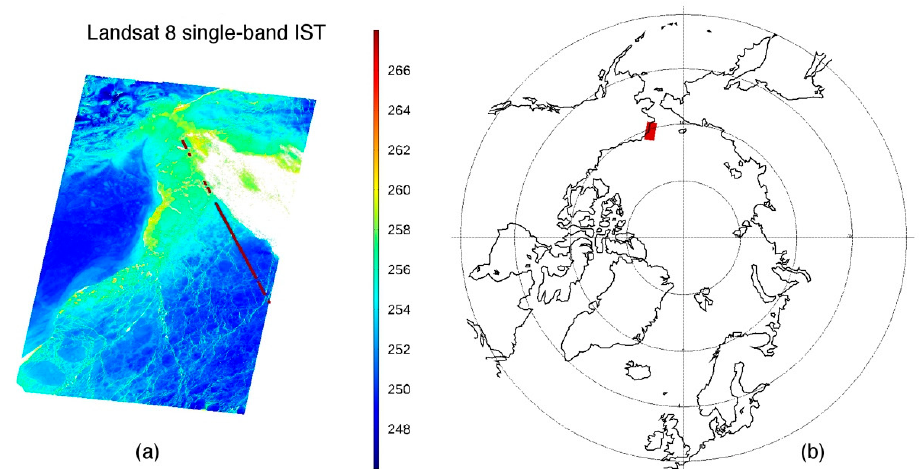
Figure 3. Landsat retrieved ice surface temperature (IST) with a P-3 Ice Bridge flight overlaid (red line) from 22:37–22:38 UTC on 19 March 2014 ( a ), off the Northwest coast of Alaska ( b ). The white color in IST field represents cloud